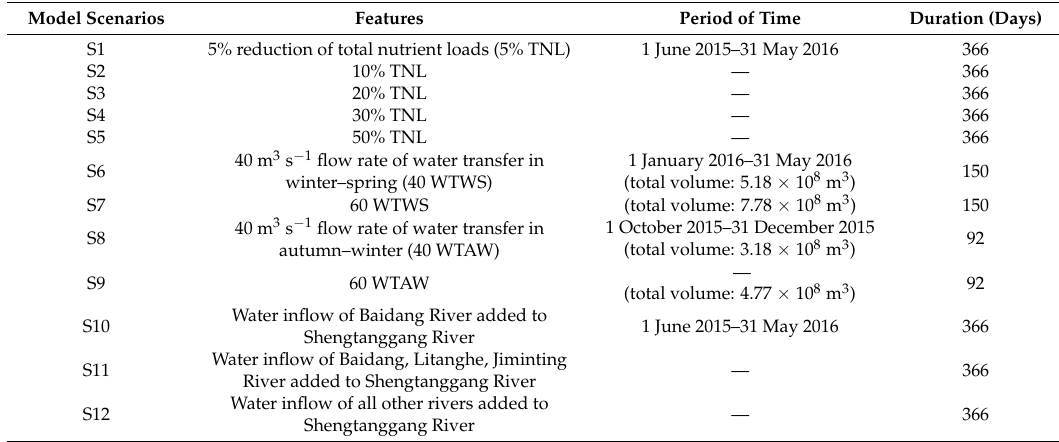
Table 2. Model setting of defined scenarios.